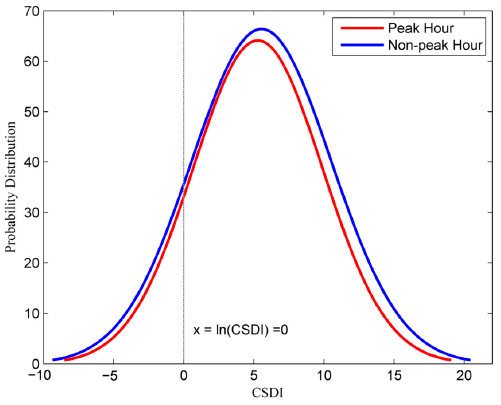
Figure 16. Normal distribution curve of CSDI.